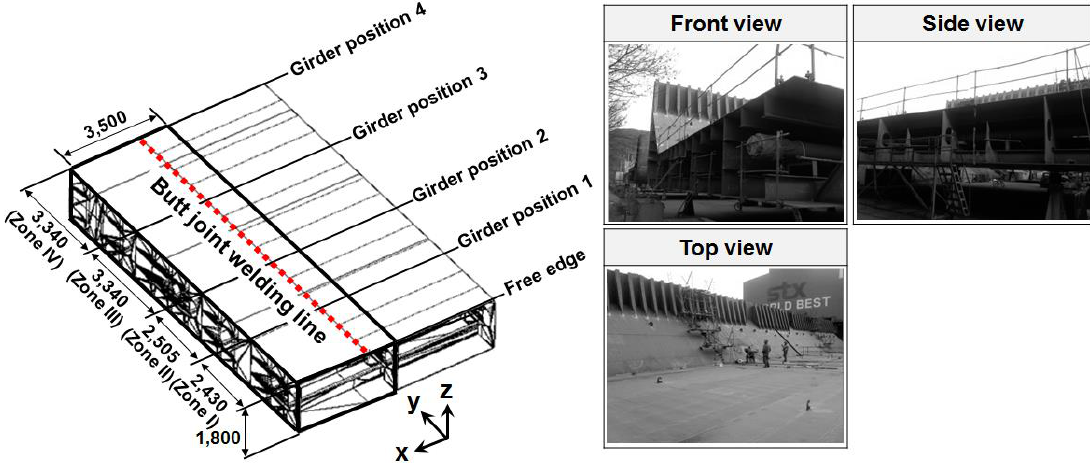
Figure 19. Panel block for simulation.